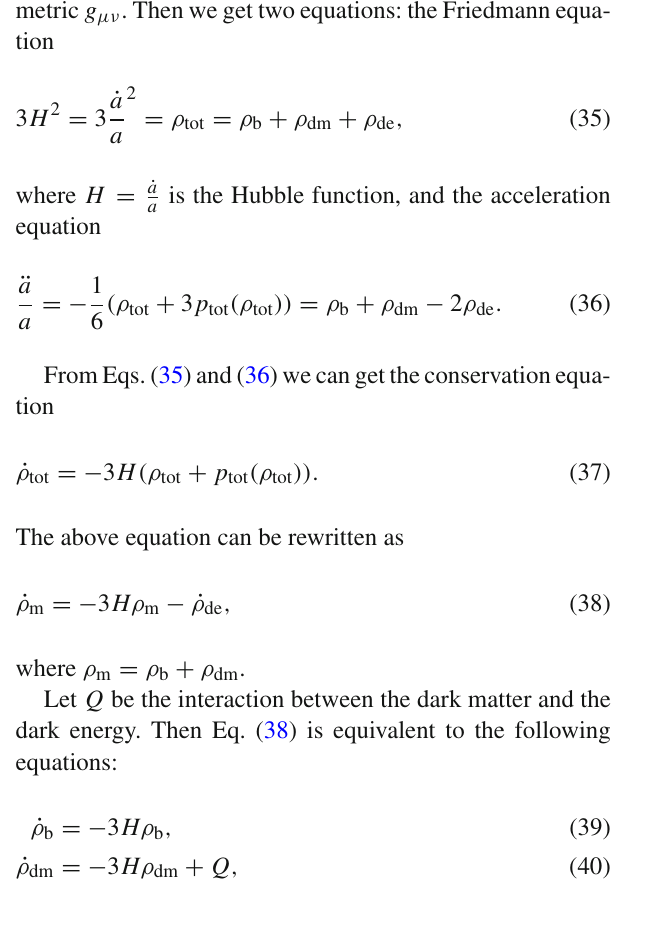
Fig. 2 The dependence (cid:5) de (τ) for α = 10 − 105 and E 0 rescaled time τ is given in units of [ 1 . 3 × 10 − 40 s